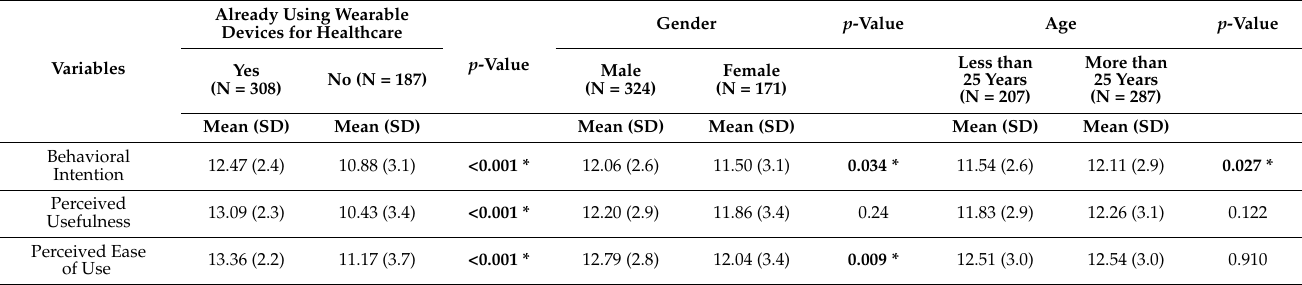
Table 3. Mean scores of different factors affecting the use of wearable devices across already usage of wearable devices, gender, and